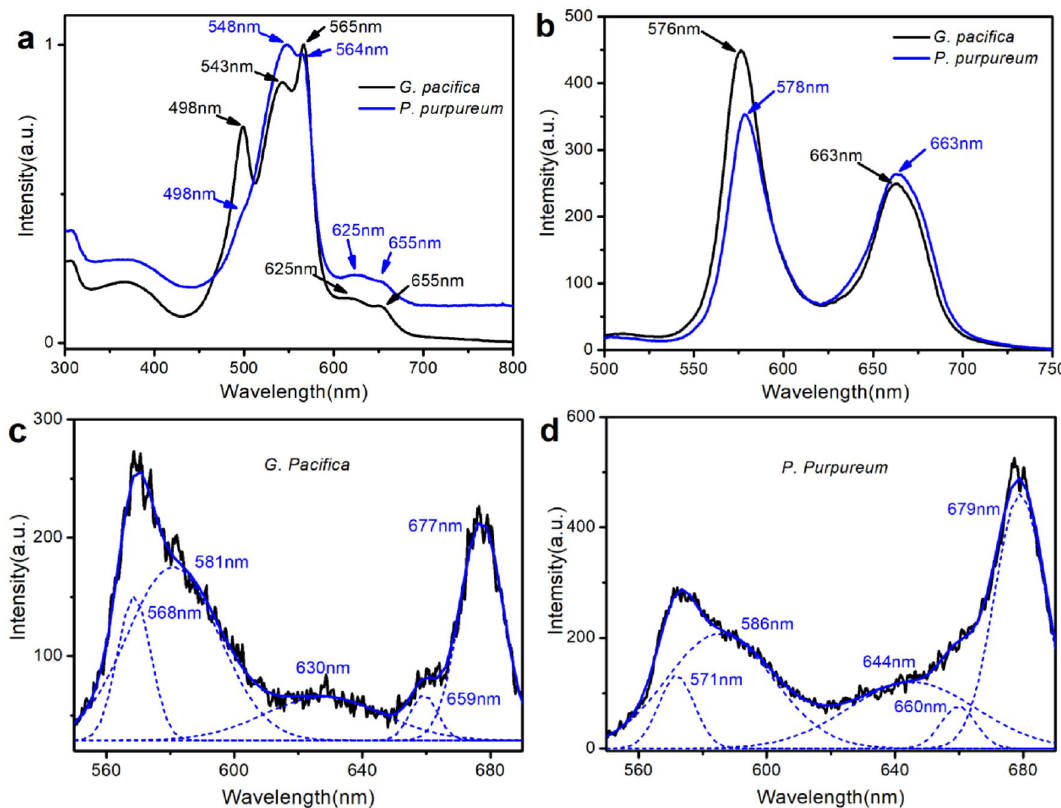
Figure 1. The steady-state spectra of two red algae PBSs. ( a ) The absorption spectra of G. pacifica PBSs and P. purpureum PBSs at room temperature; ( b ) The steady-state fluorescence spectra of G. pacifica PBSs and P. purpureum PBSs at room temperature . Excitation was done at 498 nm for both fluorescence spectra; ( c ) The fluorescence spectra of G. pacifica PBSs at 77 K; ( d ) The fluorescence spectra of P. purpureum PBSs at 77 K. Black lines represent the fluorescence data, blue dash lines represent the components well deconvoluted from fluorescence data, and blue solid lines represent the integral result of the deconvoluted components. Excitation was done at 498 nm for both fluorescence